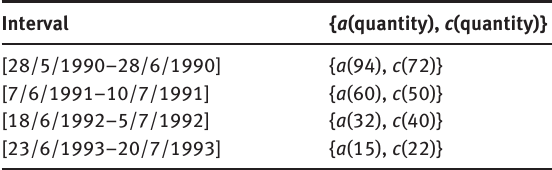
Table 2. Yearly Pattern { a , c } Along with Quantity in Four Overlapped Intervals.